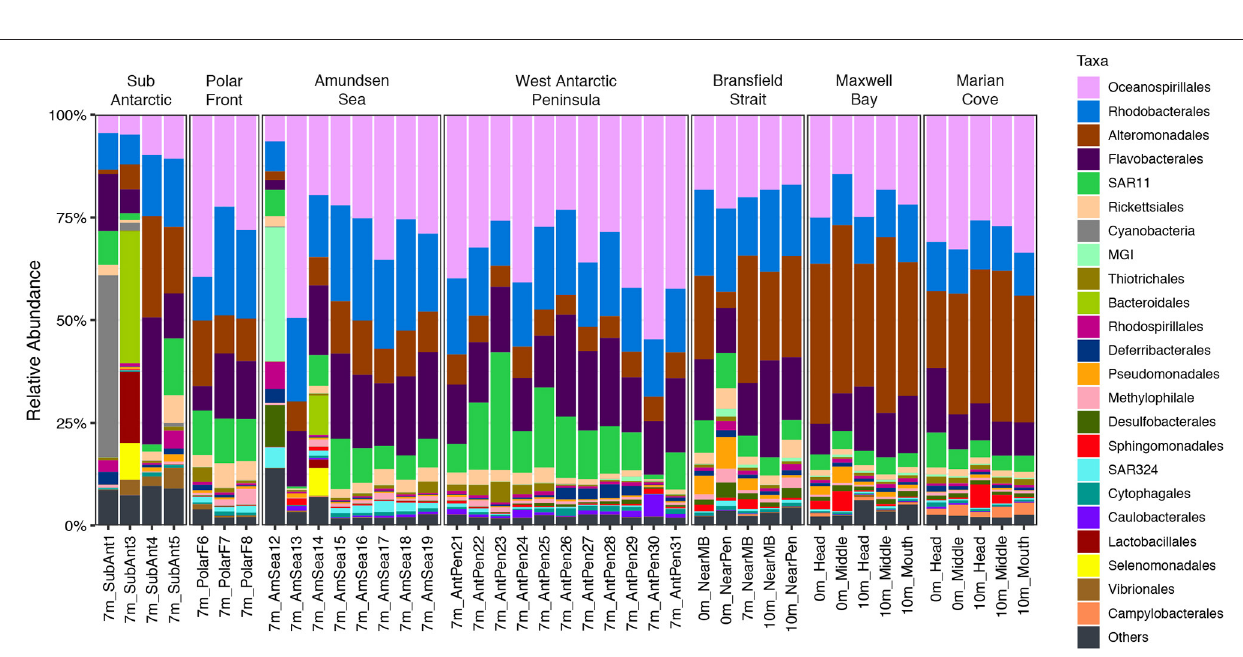
FIGURE 6 | Relative abundance of taxonomical groups at the order level in the 16S rRNA-based fraction of each zone in the upper water layer (0, 7, and 10m).